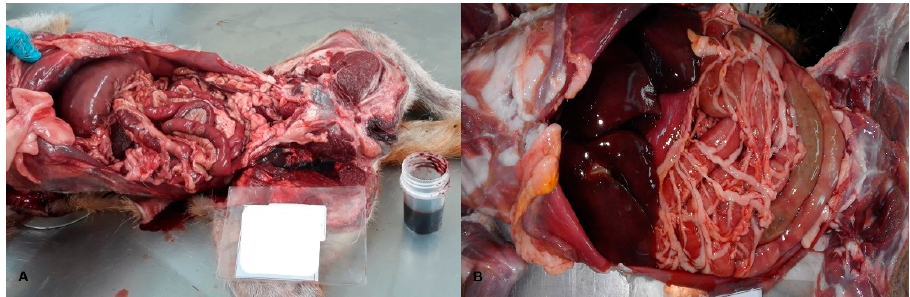
Figure 5. Generalized congestive-hemorrhagic conditions diagnosed post-mortem in dogs. ( A ): Medium-sized, female Poodle poisoned with carbamates; ( B ): Juvenile, female crossbreed poisoned with carbamates.